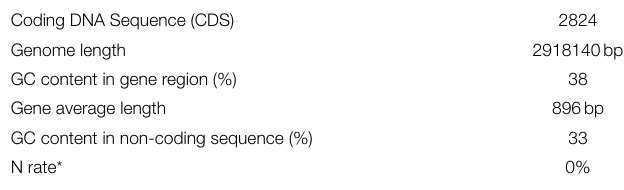
TABLE 1 | General information of the genome from E. faecalis ATCC33186 . Coding DNA Sequence